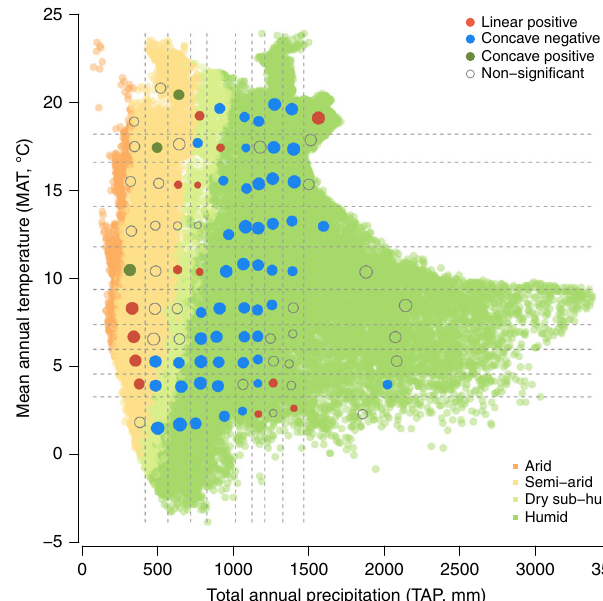
Fig. 3 Relationships between tree richness and productivity in different climatic units, determined by coef fi cients ( β 17, 18 ) estimated from a hierarchical Bayesian model illustrated in Fig. 2. The circle radius is proportional to the number of forest plots (log-transformed) in each climatic unit. A list of the coef fi cient estimates with its 95% CI is available in Supplementary Data further test the BPRs across plots within each of these climatic units. The model contains fi ve sub-models with eight variables